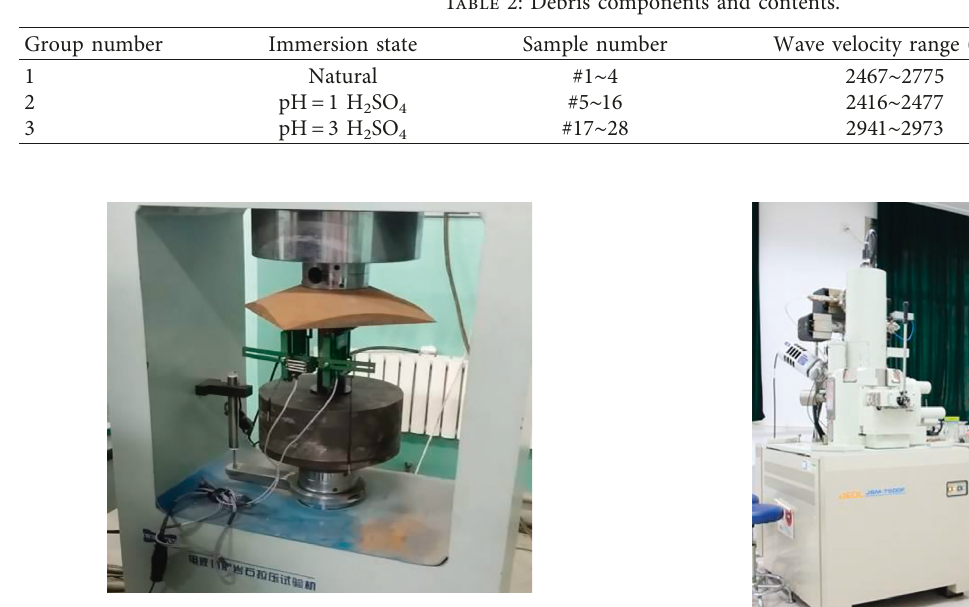
Figure 3: SEM test.